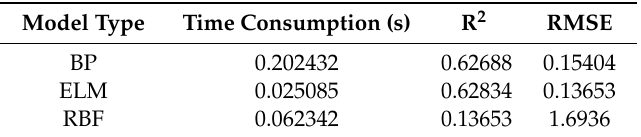
Table 2. Copper content detection models based on di ff erent neural